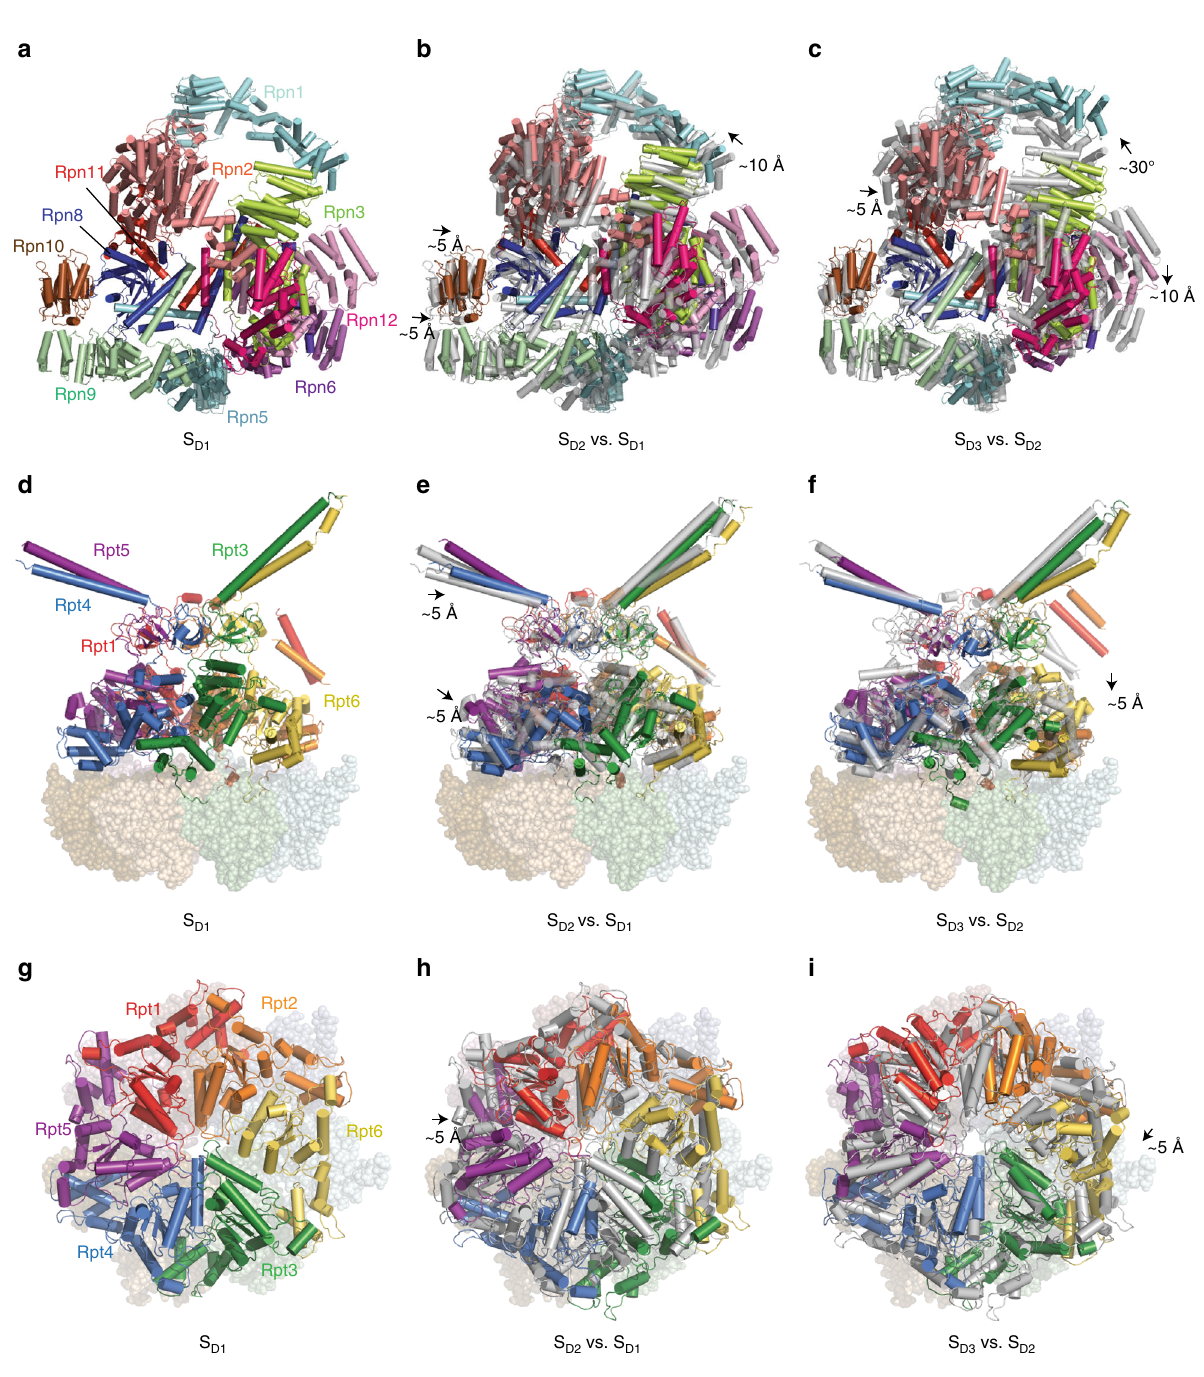
(Supplementary Fig. 9a – c). It rotates about 45° clockwise around the AAA hexameric axis in both S D1 and S D2 relative to S A (Supplementary Fig. 9d, e). Superposition of the Rpn1 – Rpt2 – Rpt1 structures in S D1 and S D2 indicates that the largest movement of Rpn1 happens in its N-terminal domain (Supplementary Fig. 9a – c). The movement of Rpn1 in the direction opposite to the motion of the AAA ring is conferred by the inter-domain rearrangement of the Rpt2 subunit, which is dependent on its nucleotide-binding state (see below).